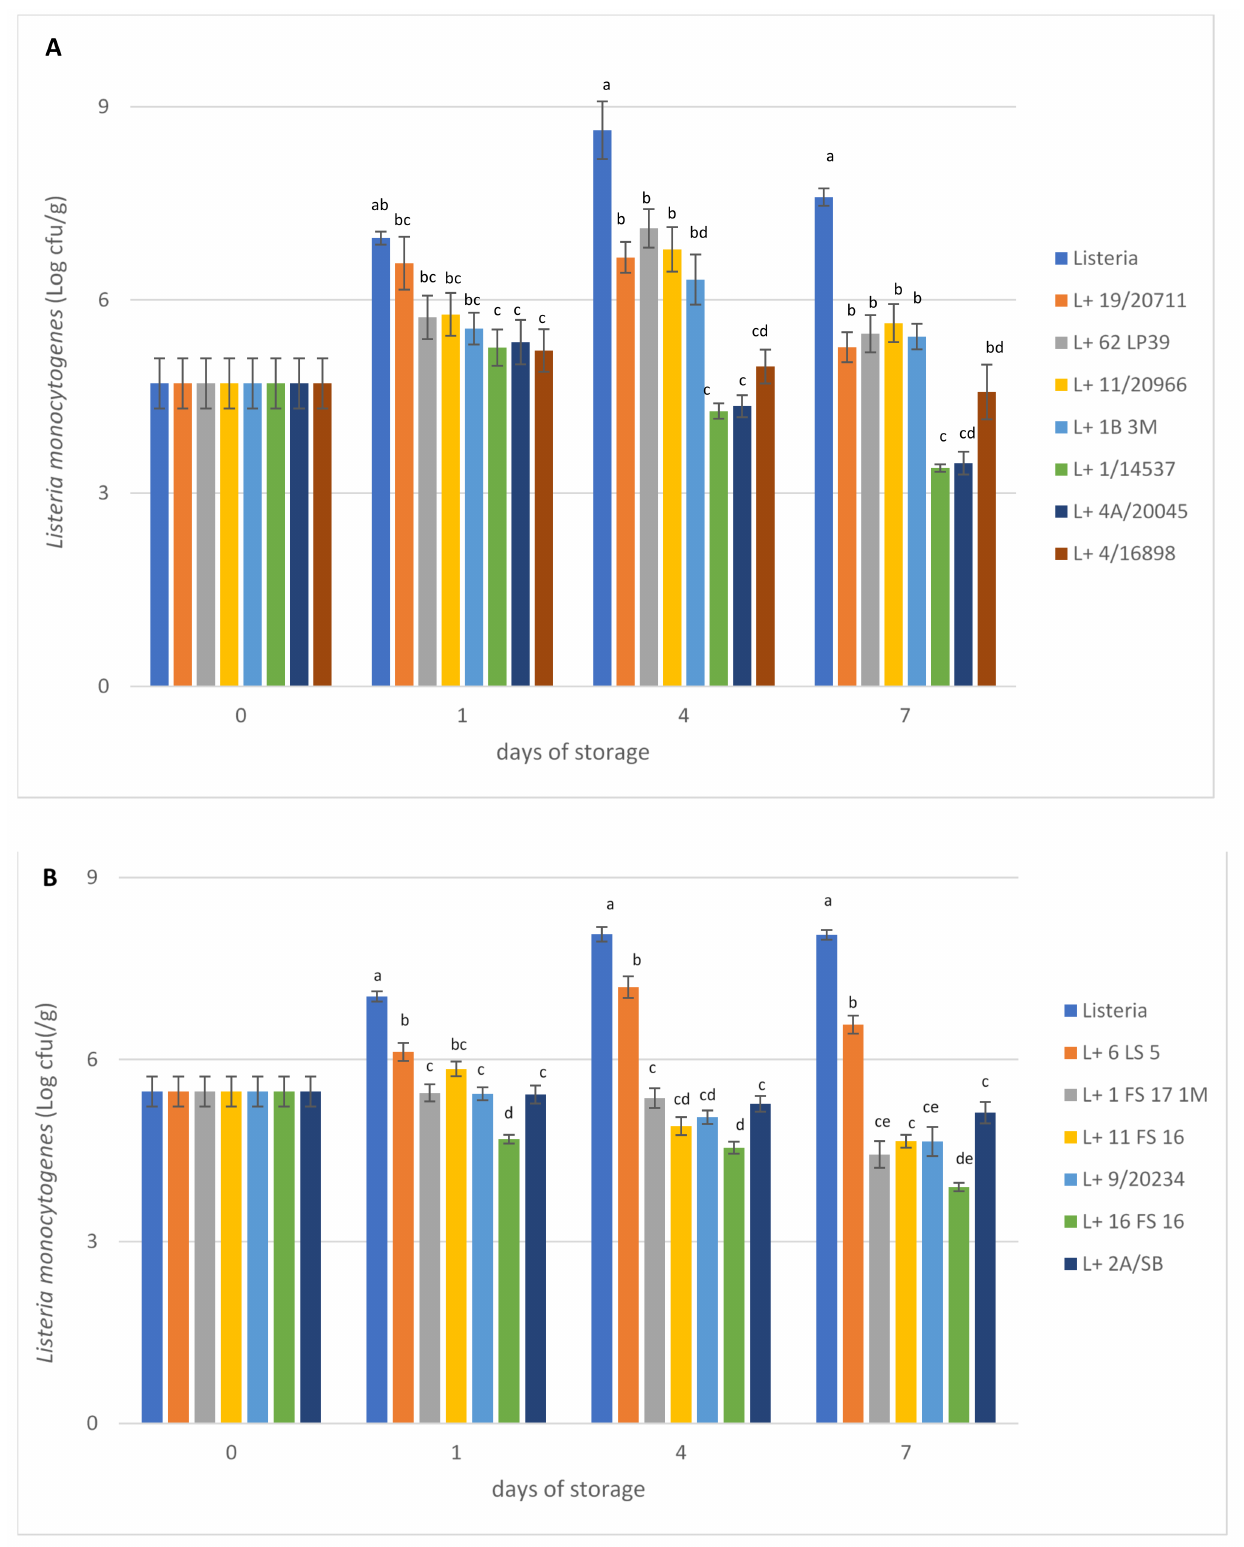
Figure 1. Effect of Lactiplantibacillus ( A ) and Lactococcus ( B ) strains on Listeria monocytogenes counts in experimental cheeses during storage (1, 4, 7 days) at 10 ◦ C (means ± SD of two samples). Means corresponding to the same storage time with different letters are significantly different ( p <